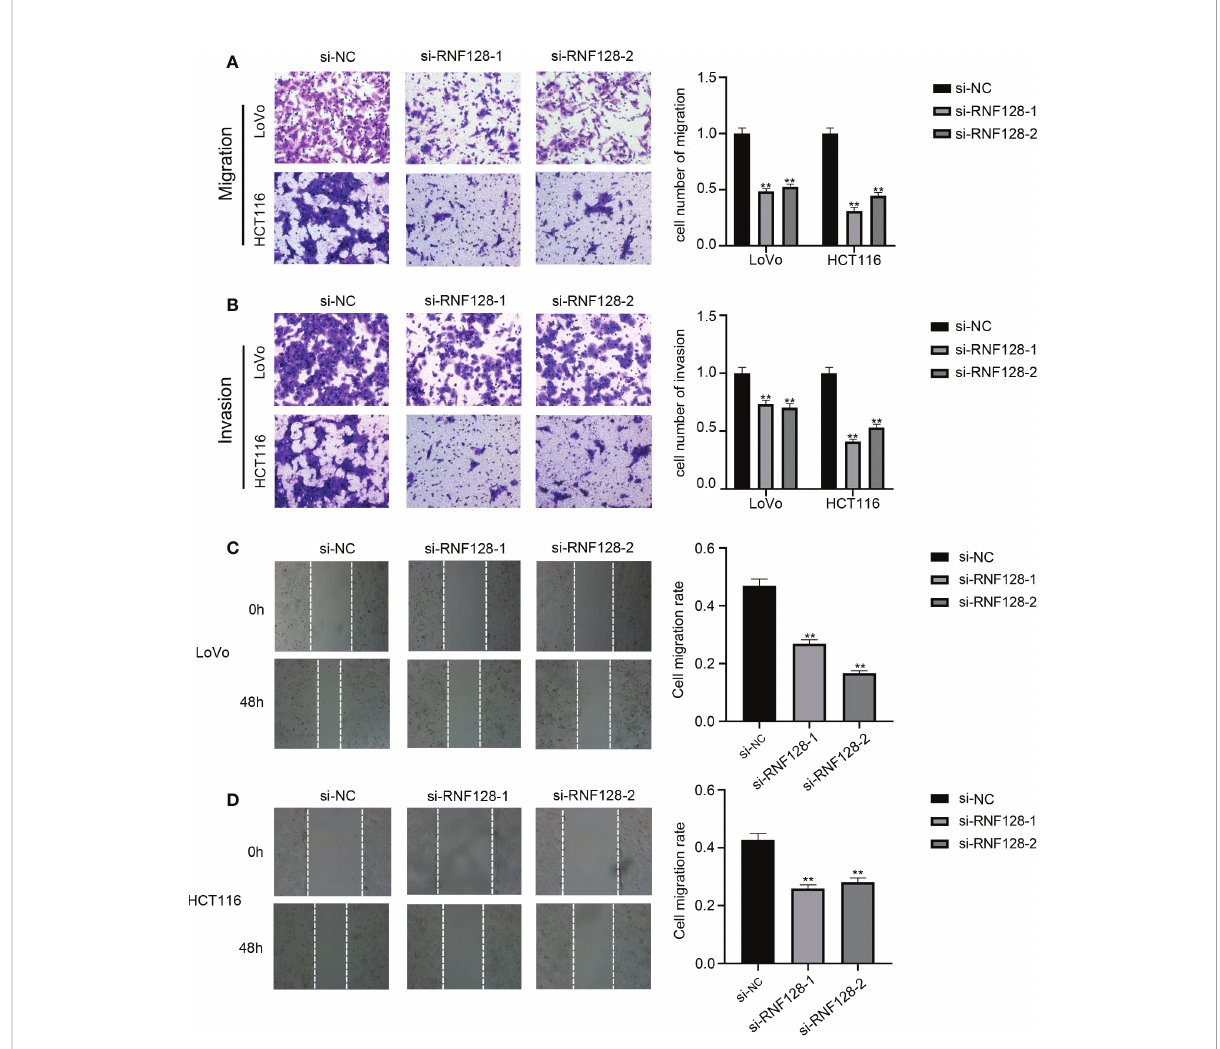
FIGURE 3 RNF128 promotes cell migration and invasion in colorectal cancer. (A, C, D) The migration abilities of LoVo and HCT116 cells were analyzed by transwell assays and wound healing assays with si-NC and si-RNF128 transfection. (B) The invasion abilities of LoVo and HCT116 cells transfected with si-NC and si-RNF128 were observed by transwell assays with Matrigel. ** P